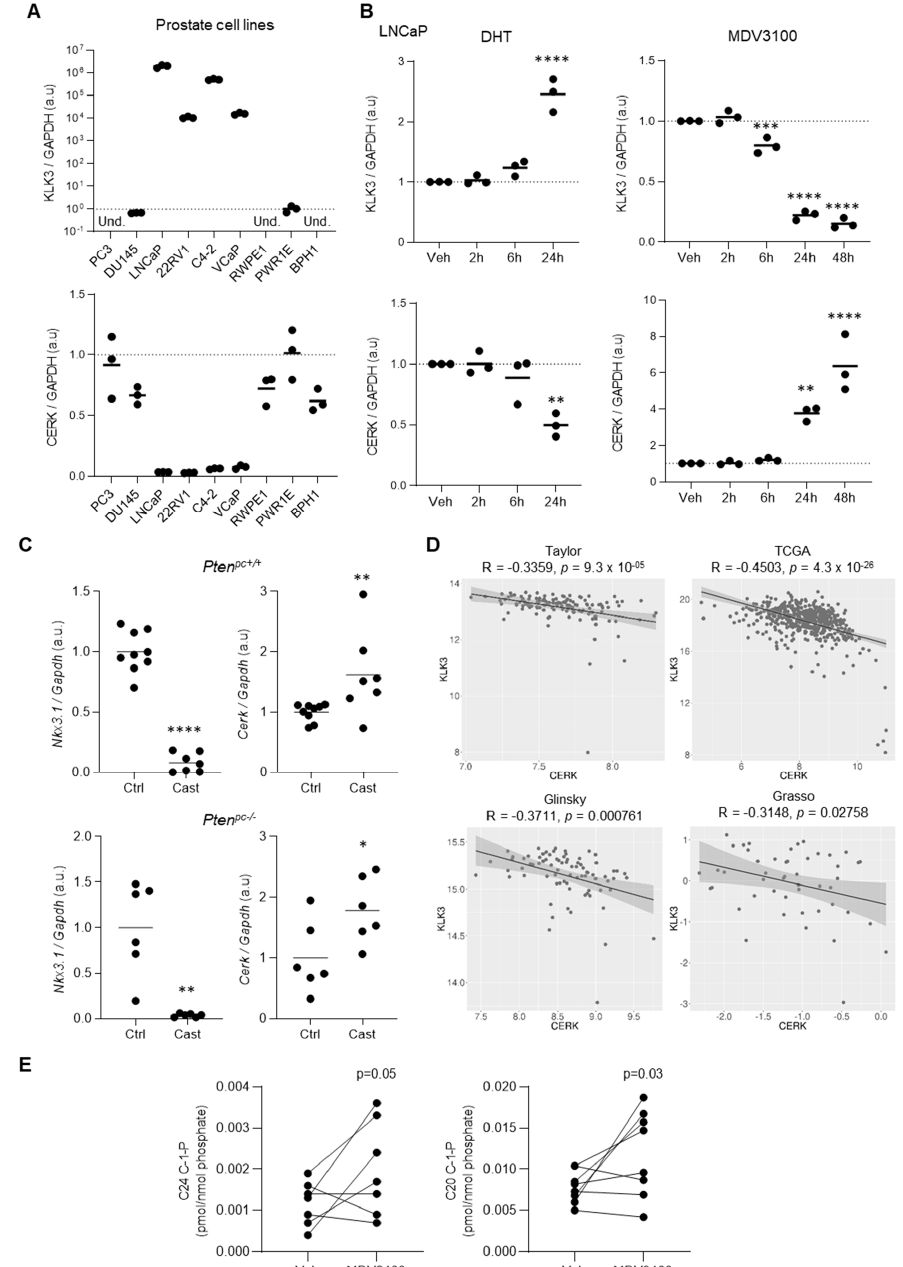
Figure 2. AR represses CERK expression. ( A ) Analysis of the AR target KLK3 and CERK gene expression by qRT-PCR in a panel of prostate cells ( n = 3 independent experiments). Data were normalized to GAPDH expression. mRNA abundance was normalized to the benign cell line PWR1E. Und. stands for undetermined. ( B ) Analysis of KLK3 and CERK gene expression by qRT-PCR upon treatment with AR agonist (dihydrotestosterone, DHT, 10 nM, left panels) or antagonist (MDV-3100, 10 µ M, right panels) in LNCaP cells ( n = 3 independent experiments). Data were normalized to GAPDH expression. ANOVA and Dunnett’s multiple comparisons test was performed. ( C ) Gene expression analysis of the AR target gene, Nkx3.1 , and Cerk by qRT-PCR in prostate-specific Pten wild type in upper panels ( Pten pc+/+ ) castrated at 4 months of age (Cast, n = 7 mice) compared to control (Ctl, n = 9 mice), and knock out mice in lower panels ( Pten pc − / − , castrated at 6 months of age, n = 6 mice per group), 6 days after performing orchiectomy. Data were normalized to GAPDH/Gapdh expression. A one-tailed Mann–Whitney test was performed. ( D ) Pearson correlation of CERK and KLK3 mRNA expression in the indicated PCa datasets. ( E ) LC/MS analysis of phosphorylated C24 and C20 ceramide species upon treatment with AR antagonist MDV-3100 (10 µ M) compared to vehicle (Veh). Paired t-test analyses were performed. * p < 0.05; ** p < 0.01; *** p < 0.001; **** p <